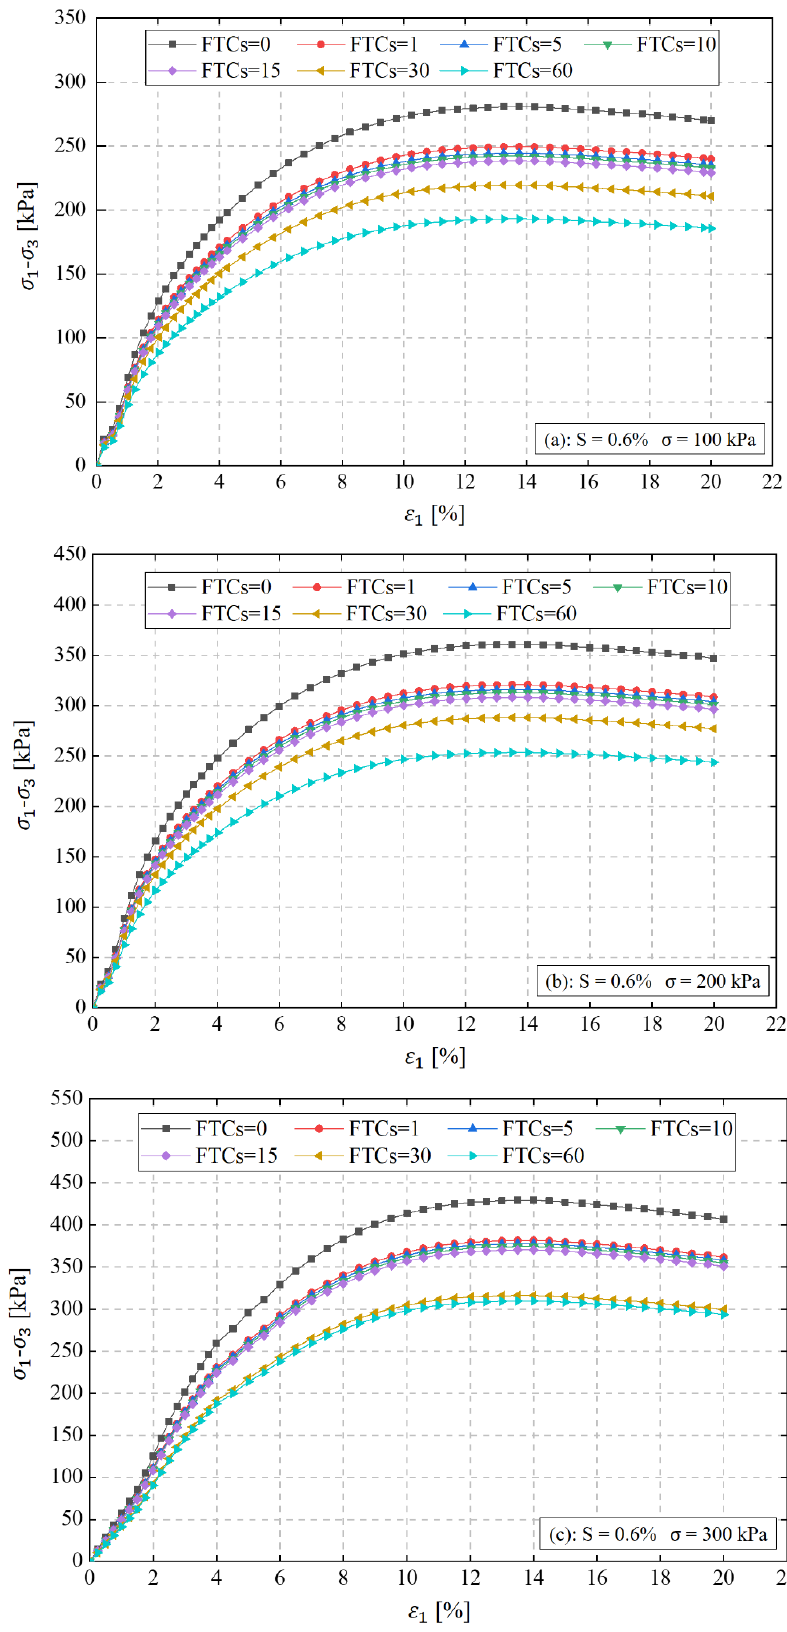
Figure 7. Stress-strain behavior of the specimens (S = 0.6%) at an increasing number of FTCs varying confining pressures. Notes: ( a ) 𝜎 3 = 100 kPa; ( b ) 𝜎 3 = 200 kPa; ( c ) 𝜎 3 = 300 kPa.